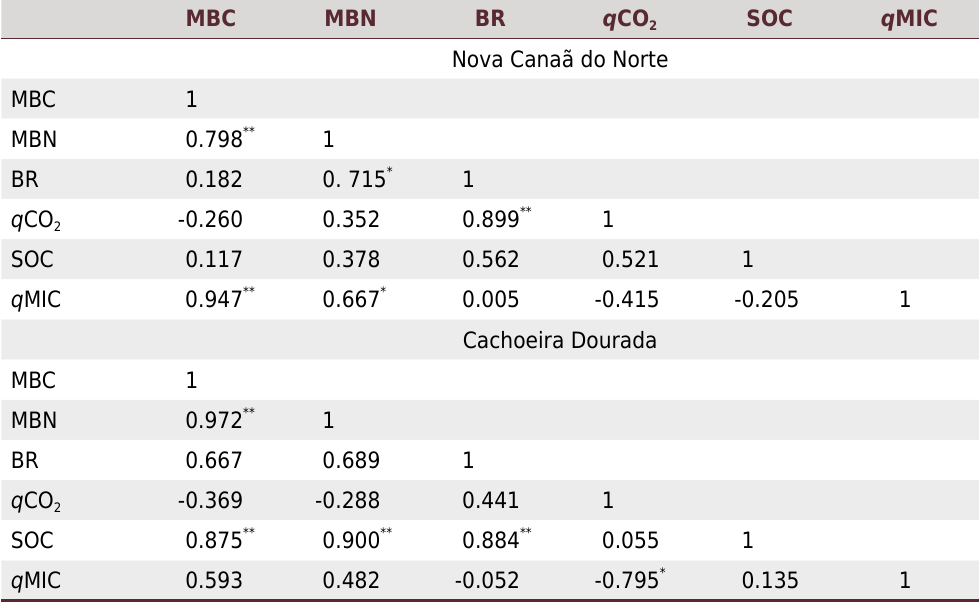
Table 3. Coefficient of correlation (r) between soil properties in the 0.0-0.10 m soil layer, in Nova Canaã do Norte, MT, and Cachoeira Dourada,